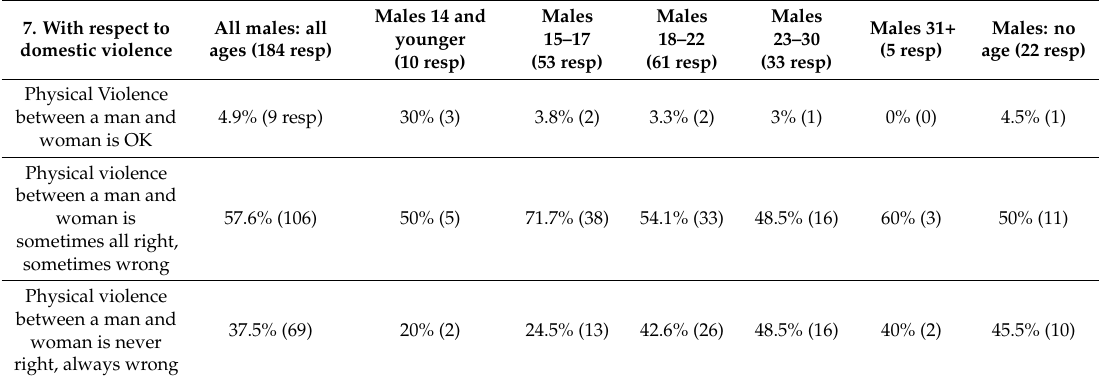
Table 11. Attitudes towards Domestic Violence—All Males.